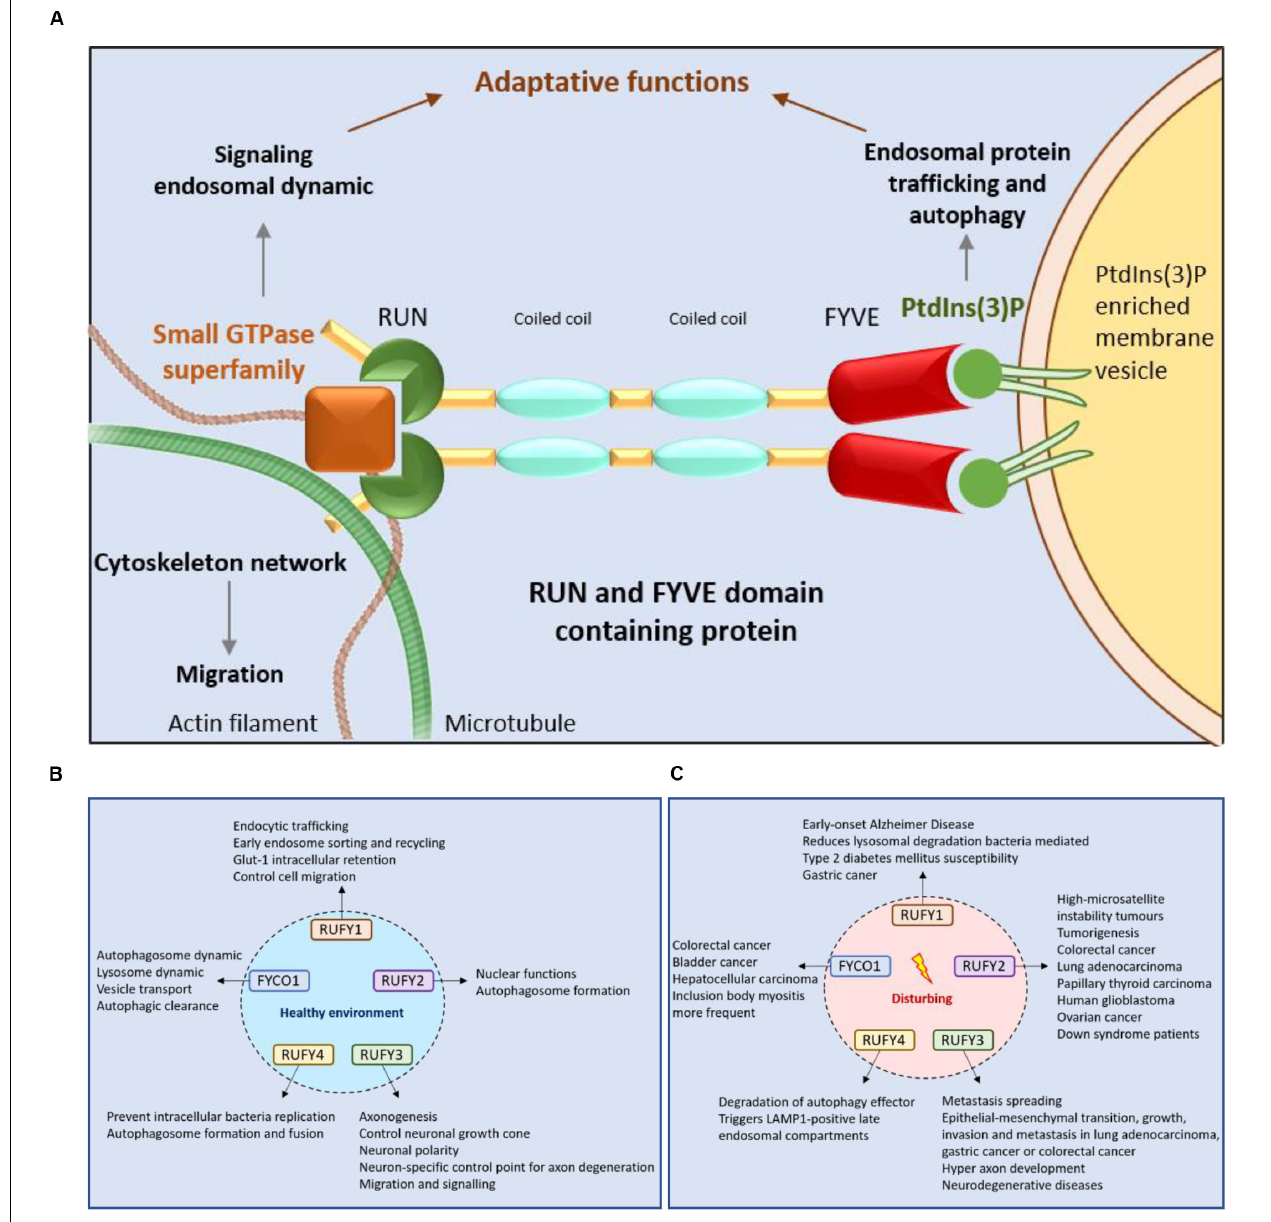
FIGURE 4 | RUFY proteins are important for intracellular trafficking, signaling and cytoskeleton dynamics. (A) Schematic representation of the RUN and FYVE domains activity of RUFY proteins. RUN domains act on signaling, endosomal protein trafficking and cytoskeletal network dynamics via small GTPase proteins. FYVE domains bind PtdIns(3)P and regulates autophagy and endosome trafficking. (B) Function of RUFY proteins in homeostatic conditions. (C) Consequences of alterations in RUFY proteins functions at the cellular and organismal